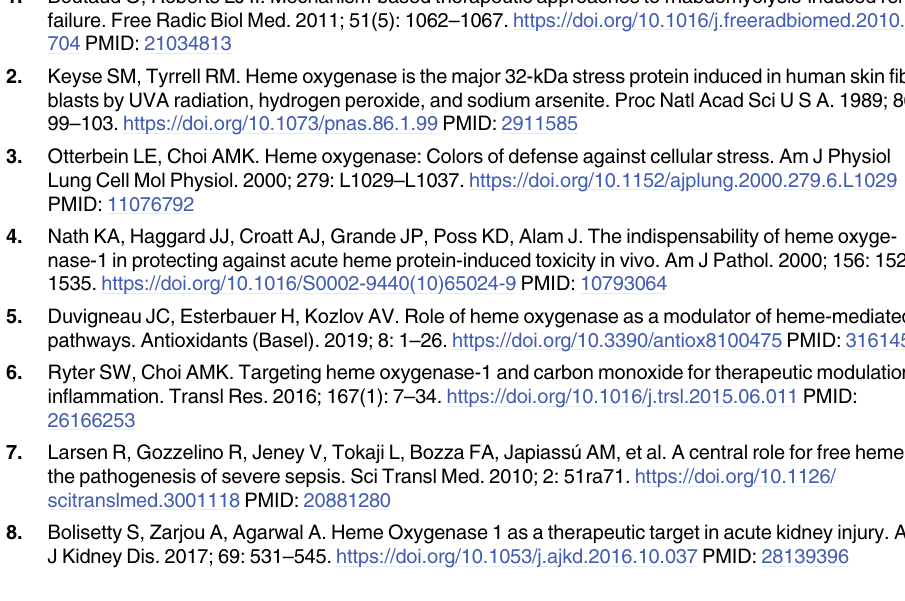
S4 Fig. Changes in the expression of renal ALAS1 mRNA levels after SnCl c.). (TIF) S5 Fig. Changes in the expression of renal nuclear Bach1 protein levels after SnCl ment (s.c.). (TIF) S1 Raw images. Original images for blots and gels.